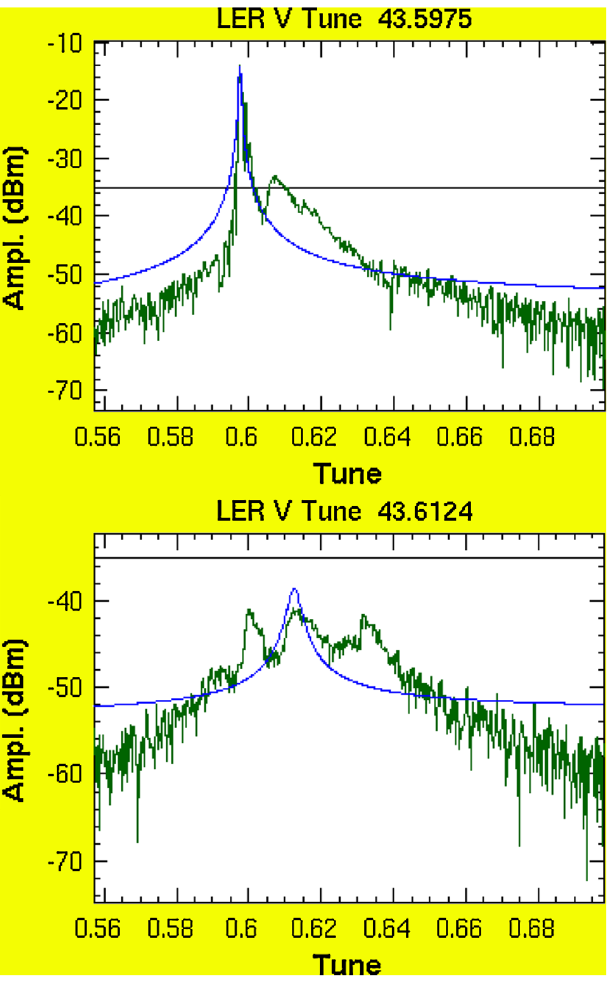
FIG. 6. (Color) Vertical tune spectra of a positron bunch while increasing the electron bunch current denoted by the green curve. The positron bunch current is 0.82 mA, while the electron bunch current is changed from 0.38 mA (upper) to 0.58 mA (lower). The blue line is a resonance curve fitted to a single